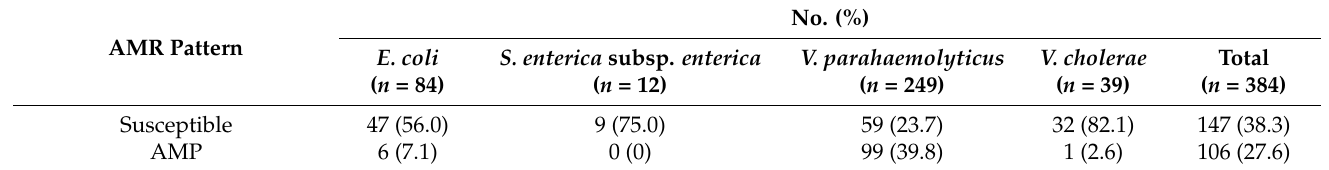
Table 2. Phenotypic resistance patterns of E. coli , S. enterica subsp. enterica , V. parahaemolyticus , and V. cholerae isolated from seawater from coastal